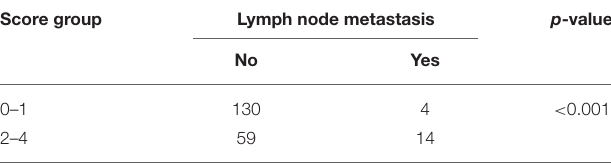
TABLE 5 | Correlation analysis clustering cases with score < 2 vs. score ≥ 2.